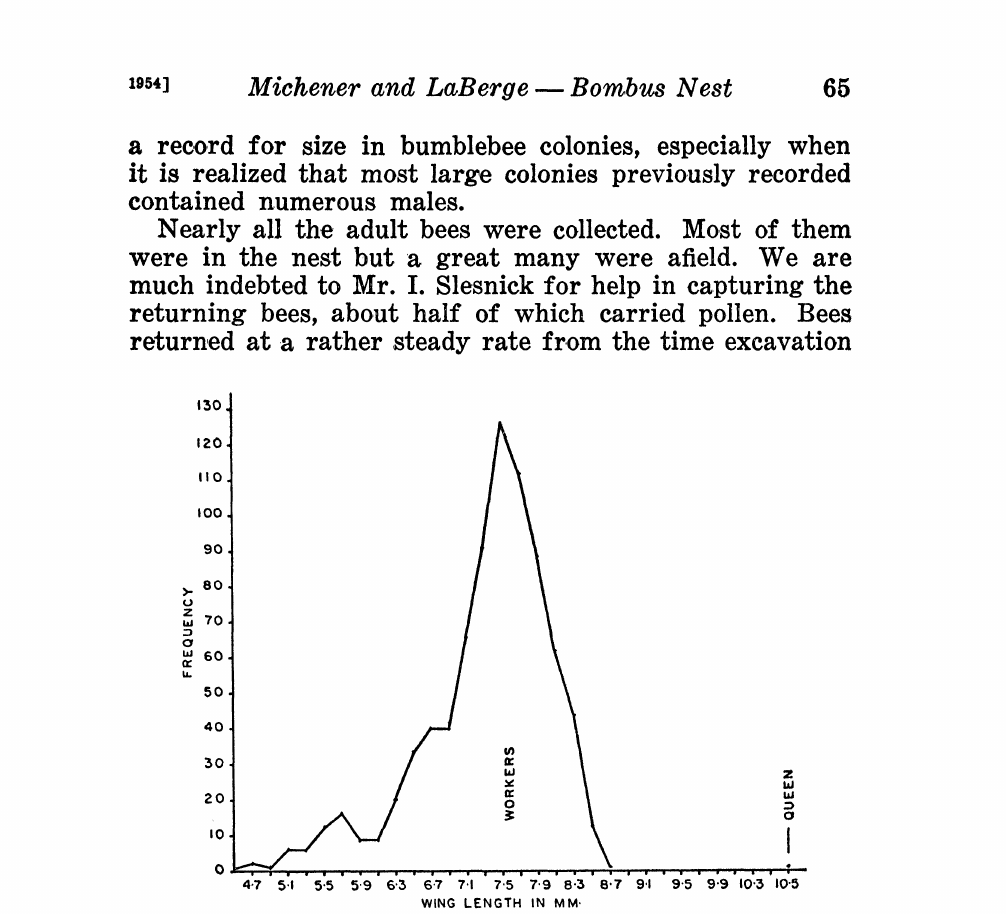
Figure 1. Frequency distribution of the size of the workers and the queen from the nest of Bombus medius Cresson based on wing length. The wings were measured from the proximal end of cell 1st M to the distal end of the marginal cell. We wish to thank Mr. Carl W. Retten- meyer for taking these